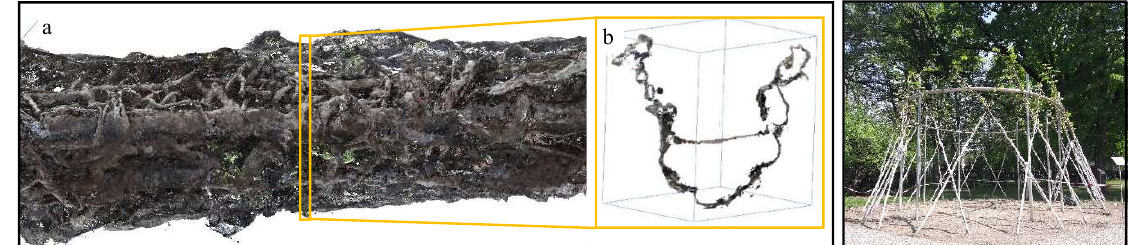
Figure 8: Baubotanik